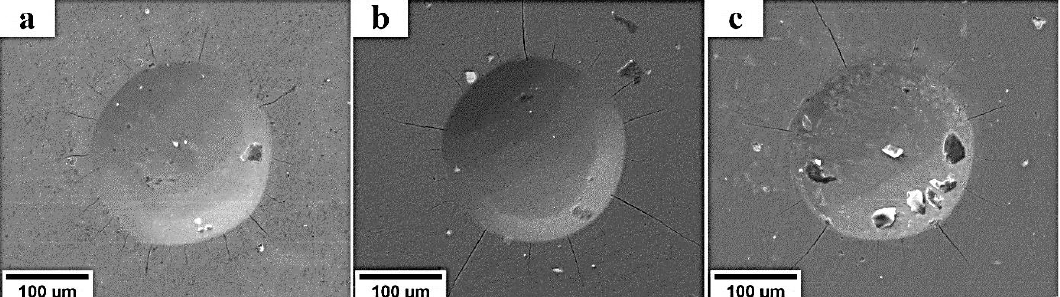
Figure 7. SEM images of indentation craters formed after the adhesion testing of the TiAlN-coated substrate surface: ( a ) at the floating potential and substrate bias voltages of ( b ) − 50 V and ( c ) − 100 V.